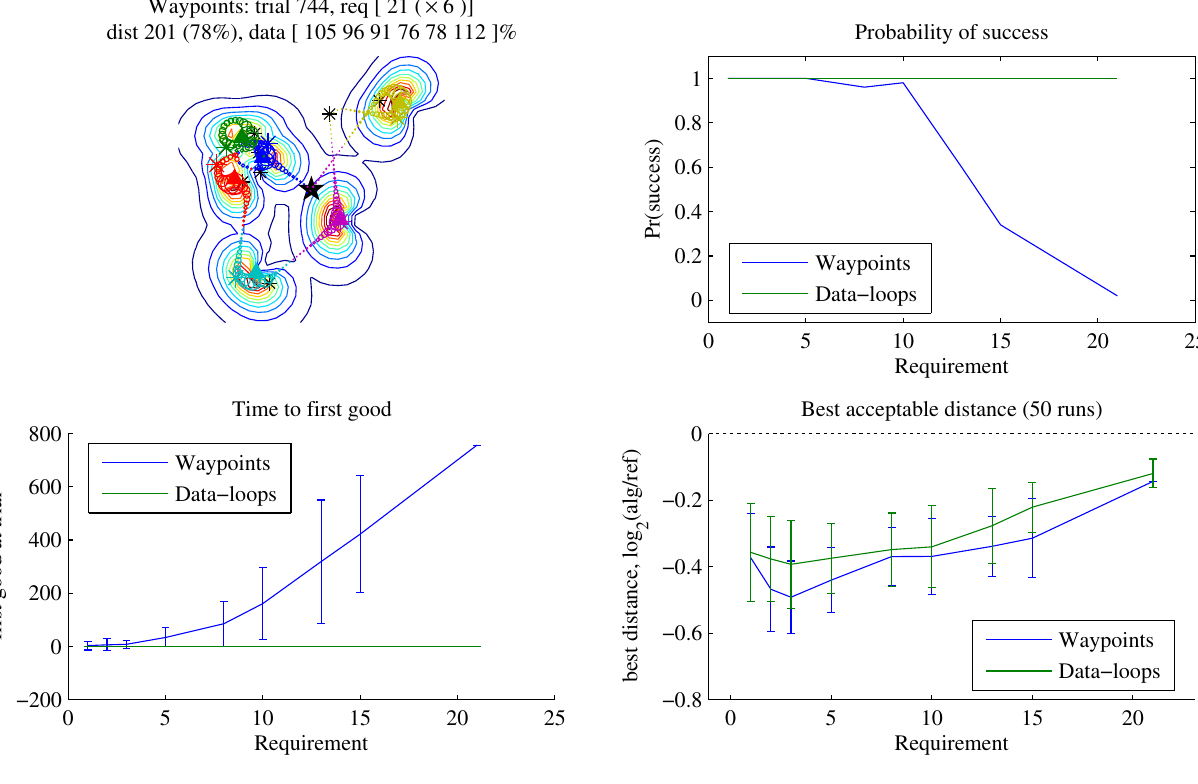
Figure 3. Asymptotic trajectory quality as data load increases. Each autopilot was trained for 1,000 trials. The Waypoints autopilot was initialised with 2 waypoints/node. For each run, 6 nodes were randomly placed on a 20 × 20 field. Top left: the best Waypoints trajectory found on a sample field (the trajectory shown is not acceptable: four of the six nodes transmit less than 100% of their data). Top right: as the data requirement increases, the probability of the Waypoints learner discovering an acceptable trajectory decreases. Bottom left: Data-loops always achieves 100% collection; Waypoints requires some number of trials before doing so, and that number grows as the data requirement increases. Bottom right: length of best acceptable trajectory, averaged over cases in which one was found. The scale is the log of trajectory length compared to Reference. When Waypoints finds an acceptable trajectory, it is usually shorter than the best found by Data-loops by amounts in the order of ∼ 2 0 . 06 = 4% . Note that the error bars show standard deviation of length with respect to